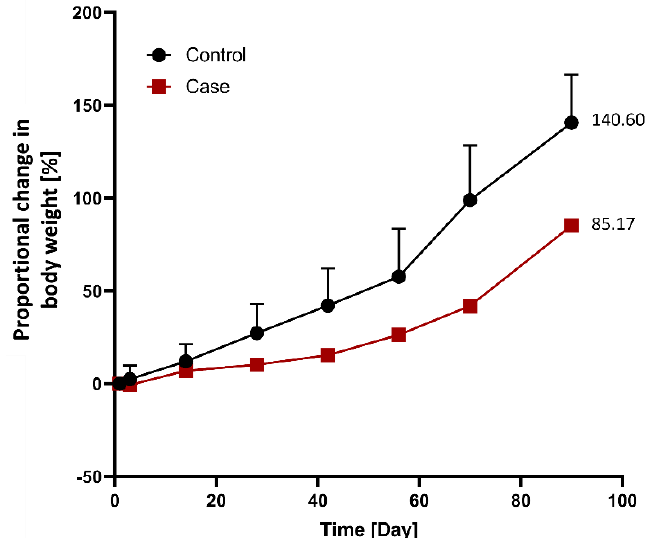
Figure 4. Comparison of the proportional changes in body weight between the control ( n = 3) and case ( n = 1) groups following G-DFR placement based on observation periods. The relative weight loss in the case group compared to that in the control group was as follows: 3.2% (2.5 vs. − 0.7) at 3 days, 5.0% (12.0 vs. 7.0) at 14 days, 17.0% (27.3 vs. 10.3) at 28 days, 26.8% (42.2 vs. 15.4) at 42 days, 31.4% (57.7 vs. 26.3) at 56 days, 56.9% (98.8 vs. 41.9) at 70 days, and 55.4% (140.6 vs. 85.2) at 90 days after G-DFR placement. G-DFR, Gastro-duodenal flow restrictor.